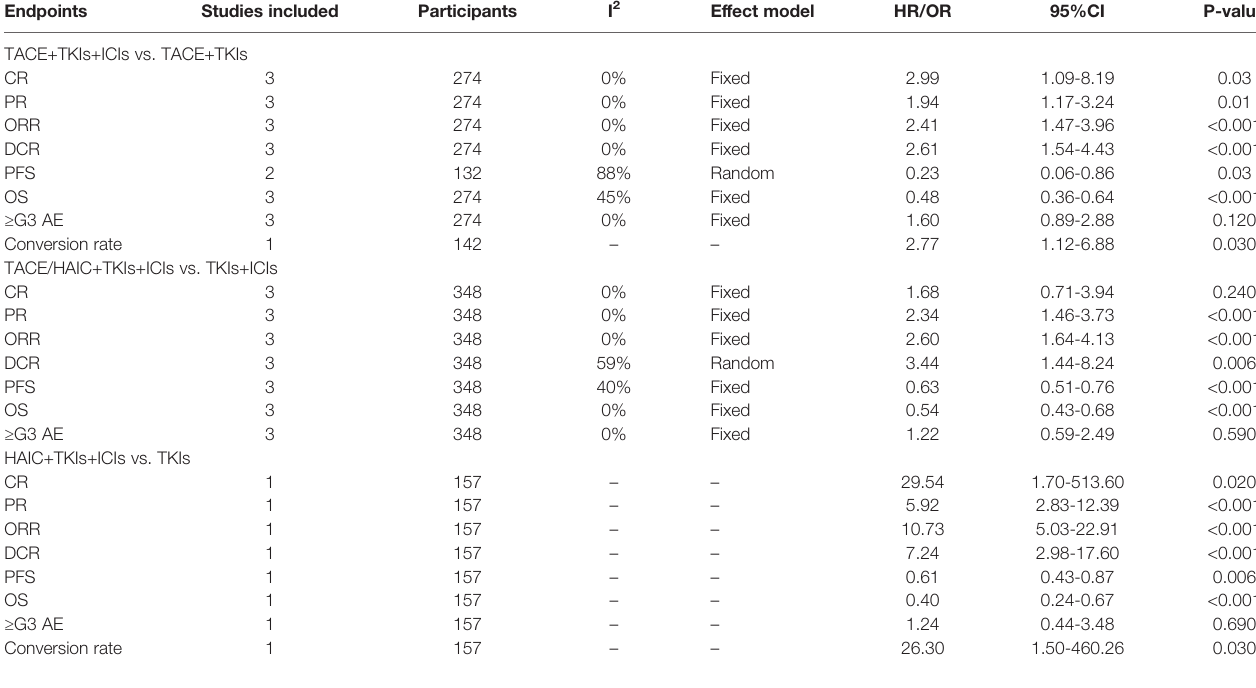
TABLE 5 | Subgroup analysis strati fi ed by the administration and regimes in control group.